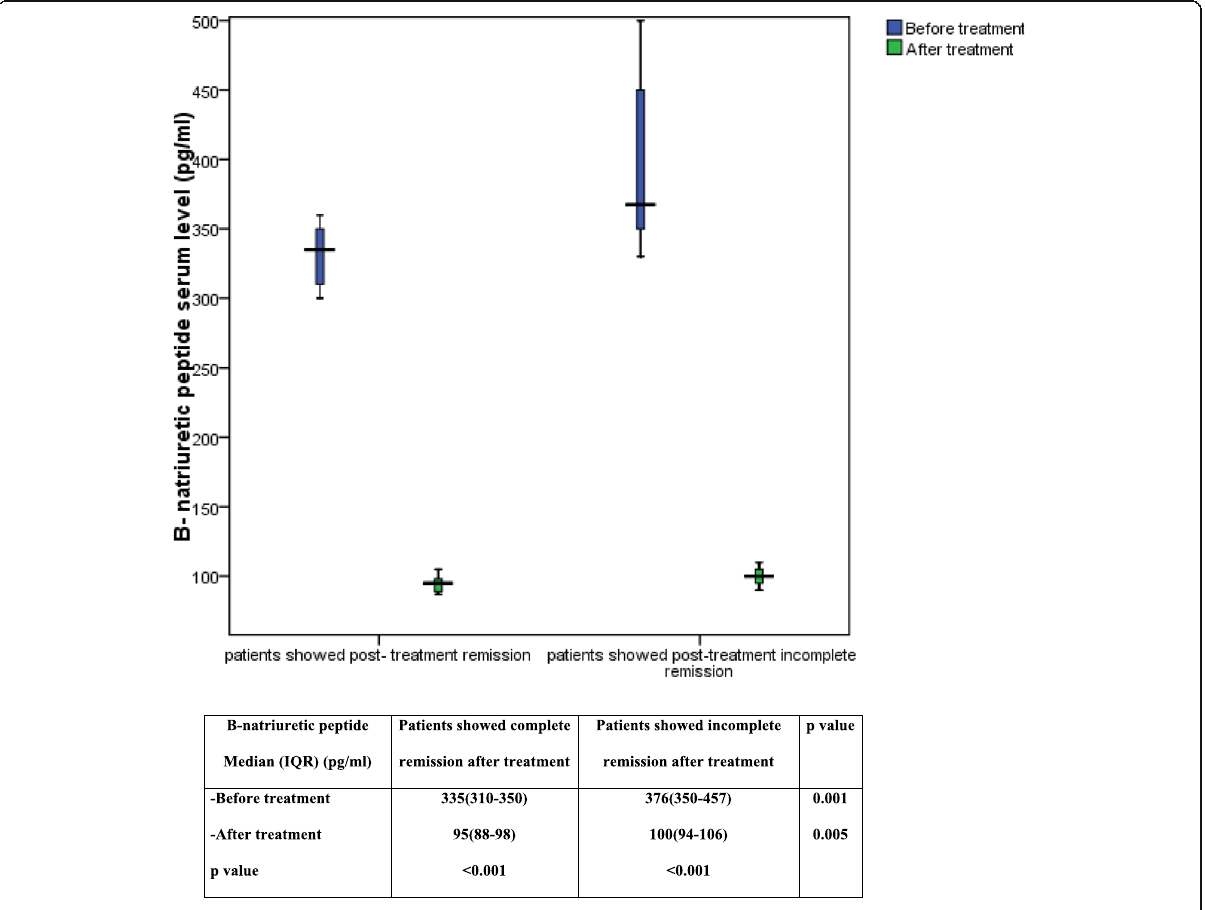
Fig. 2 Comparisons of B-natriuretic peptide (BNP) serum levels among patients that showed complete remission after treatment and those who did not show complete post-treatment remission. Both patients who experienced remission and those who did not experience remission after treatment showed a significant reduction of post-treatment BNP serum levels compared to pre-treatment levels. However, the group of patients who showed remission had lower pre-treatment and post-treatment BNP serum levels, compared to patients who did not show complete